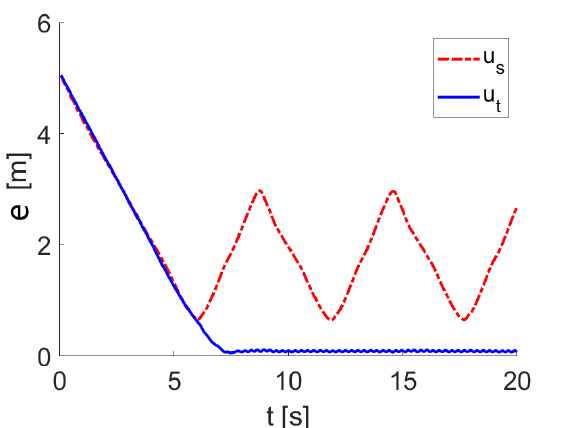
Figure 13. Errors of position regulation obtained by u s and u t for the AUV of F t , where, in the target dynamics, the maximal thrust of the four horizontal thrusters were modified to 50 N , 80 N , 10 N , and 50 N